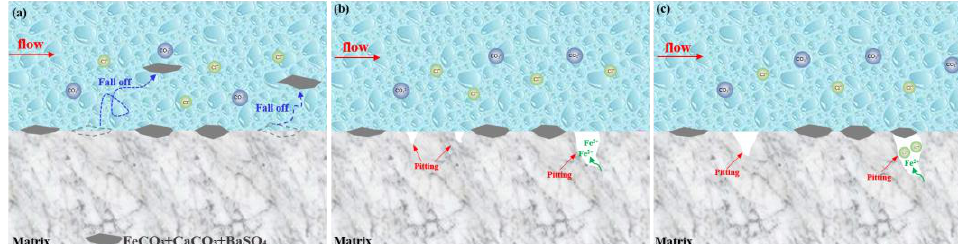
Figure 15. Schematic diagram of under-deposit corrosion mechanism in failed tubing. ( a ): Loose corrosion scales fall off; ( b ): concentration cell; ( c ): chloride ions penetrate FeCO 3 .